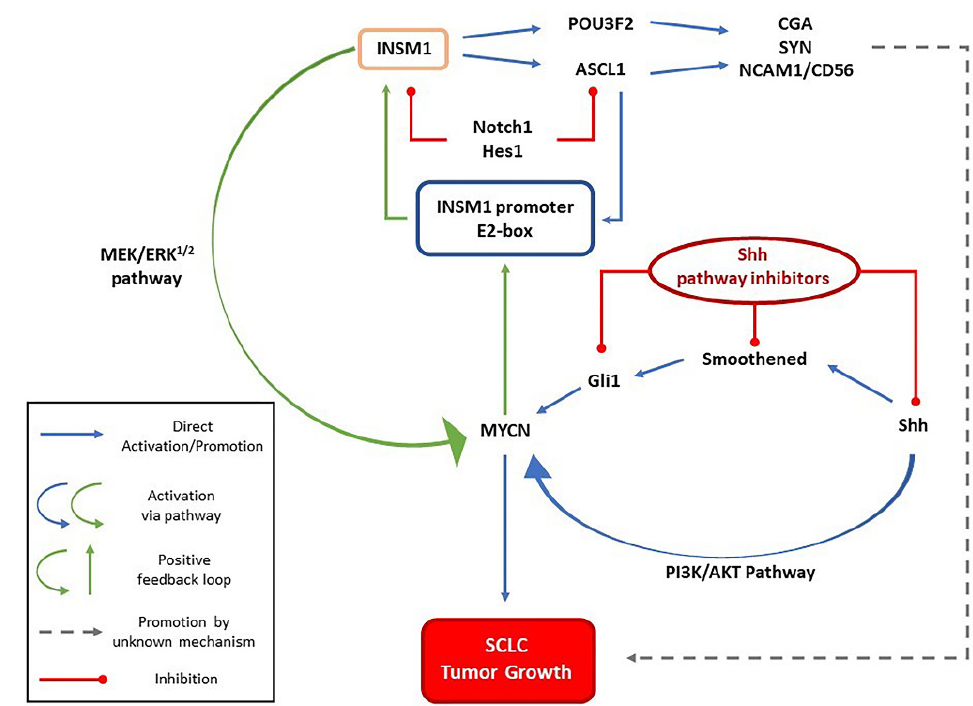
Figure 1. Intervention of INSM1 in SCLC oncogenic molecular pathways. INSM1 participates in different molecular pathways that may promote SCLC oncogenesis. INSM1 regulates POU3F2 alongside ASCL1 in SCLC cell lines, which sequentially promote the expression of NE molecules such as CGA, SYN, and NCAM1/CD56, which have been shown to promote SCLC tumor growth through unknown mechanisms [4,38]. Notch1 and Hes1 inhibit both INSM1 and ASCL1 [4]. MYCN and ASCL1 can bind to the INSM1 promoter E2-box, upregulating INSM1 . Additionally, MYCN has been shown to promote SCLC tumor growth [77]. INSM1 can activate MYCN via the MEK/ERK 1/2 pathway, which then binds to the INSM1 promoter E2-box, causing further MYCN activation and forming a positive feedback loop (in green) that promotes tumor growth. MYCN is also activated by Shh either by the PI3K/AKT pathway or Shh pathway [77]. The inhibition of SCLC tumor growth was achieved by the blockage of the Shh pathway using different inhibitors